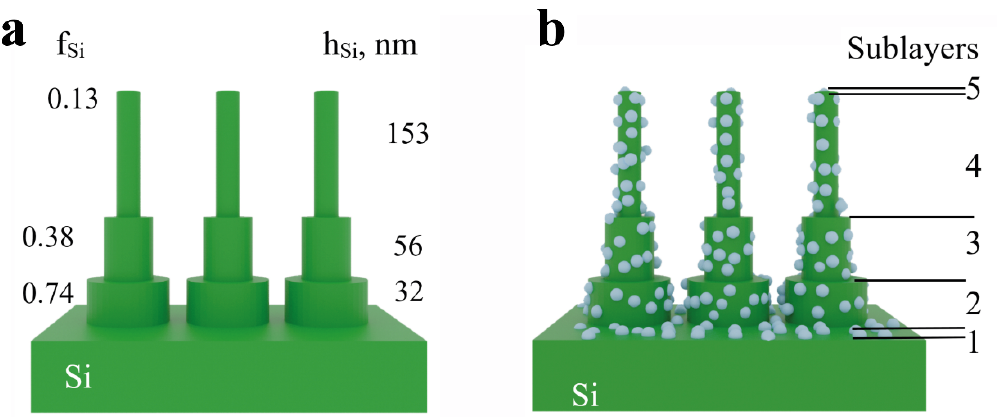
Figure 6. ( a ) Schematic model for the structure of SiNWs (sample S1), calculated heights h Si and Si fractions f Si within the three-layer structure of composite “Si/void” sublayers according to the B-EMA model; ( b ) model for the Ag/SiNW structure with AgNP layers on the entire surface of